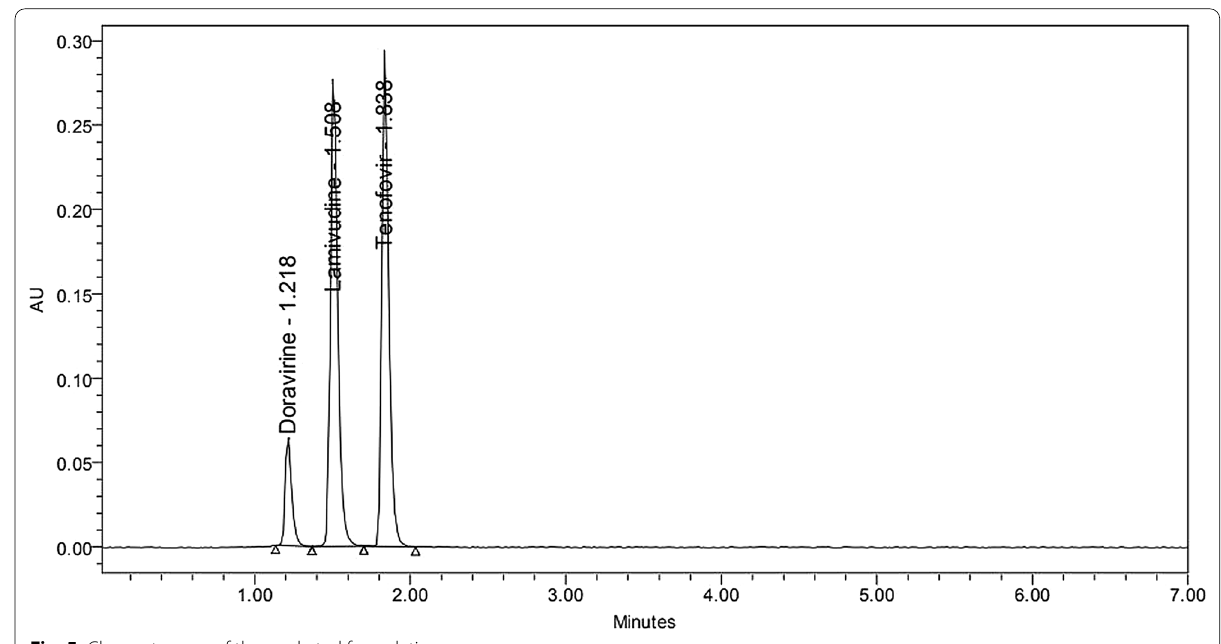
Fig. 5 Chromatogram of the marketed formulation